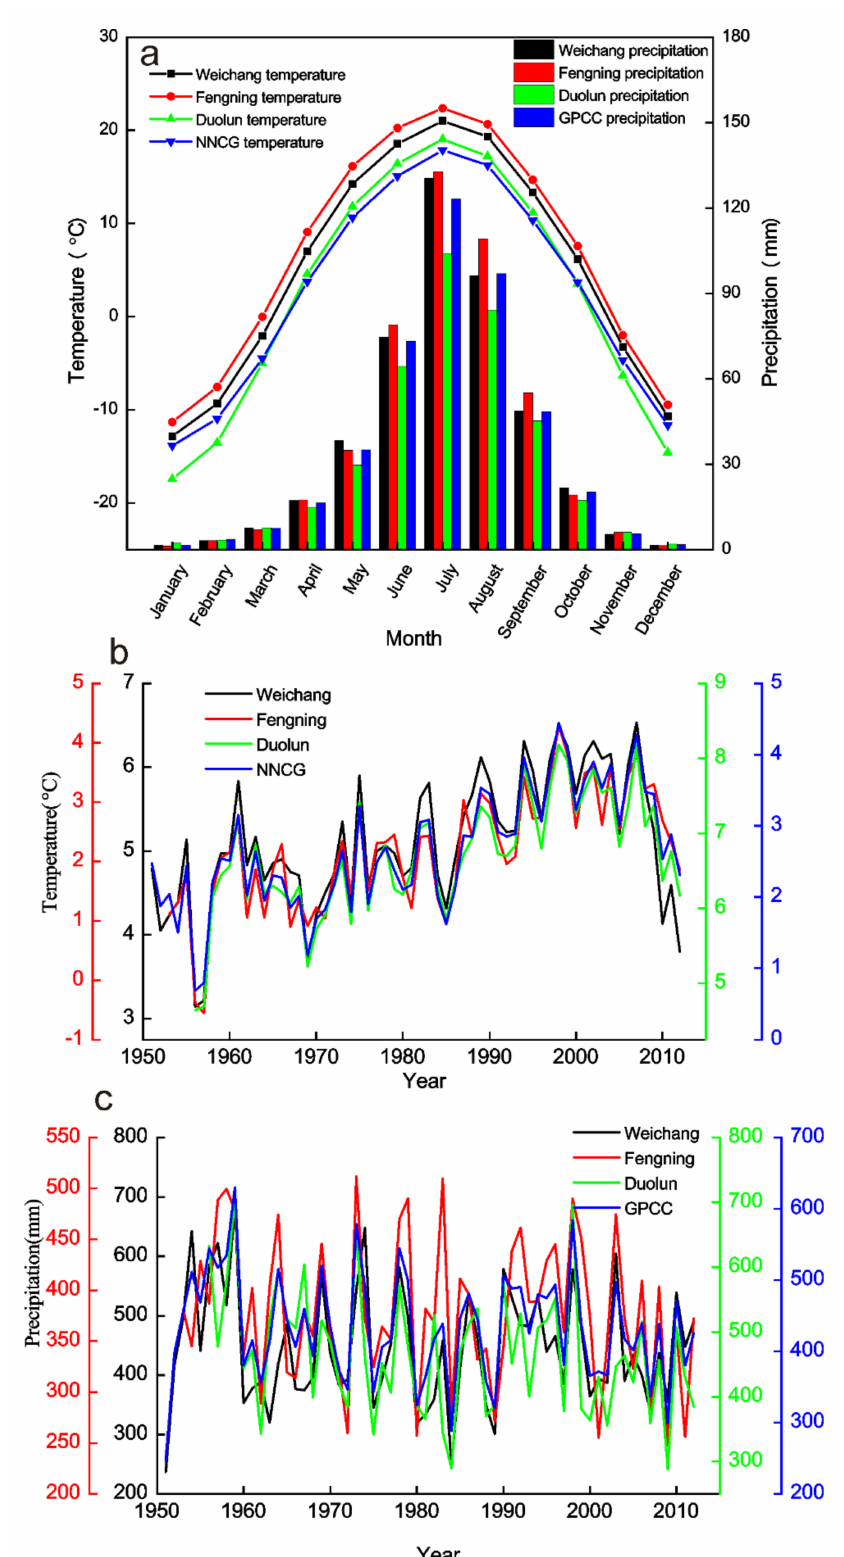
Figure 3. ( a ) The monthly mean temperature and precipitation, ( b ) The mean temperature records ( c ) The annual precipitation records at from the Duolun, Weichang and Fengning stations, and the Climate Research Unit temperature (NOAA NCEP CPC GHCN_CAMS gridded dataset (NNCG)) and precipitation (Global Precipitation Climatology Centre